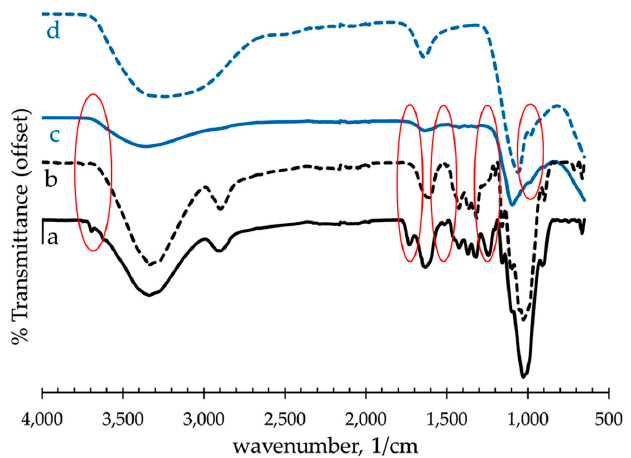
Figure 7. Fourier Transform Infrared Spectroscopy (FTIR) spectra of: ( a ) untreated abaca; ( b ) NaOH-treated abaca; ( c ) NaOH + Al 2 (SO 4 ) 3 treated abaca; and ( d ) precipitate or residue from the spent solution of Al 2 (SO 4 ) 3 treatment. Table 4. Functional Groups of Observed Bands in FTIR spectra of abaca fiber [25,42,43].